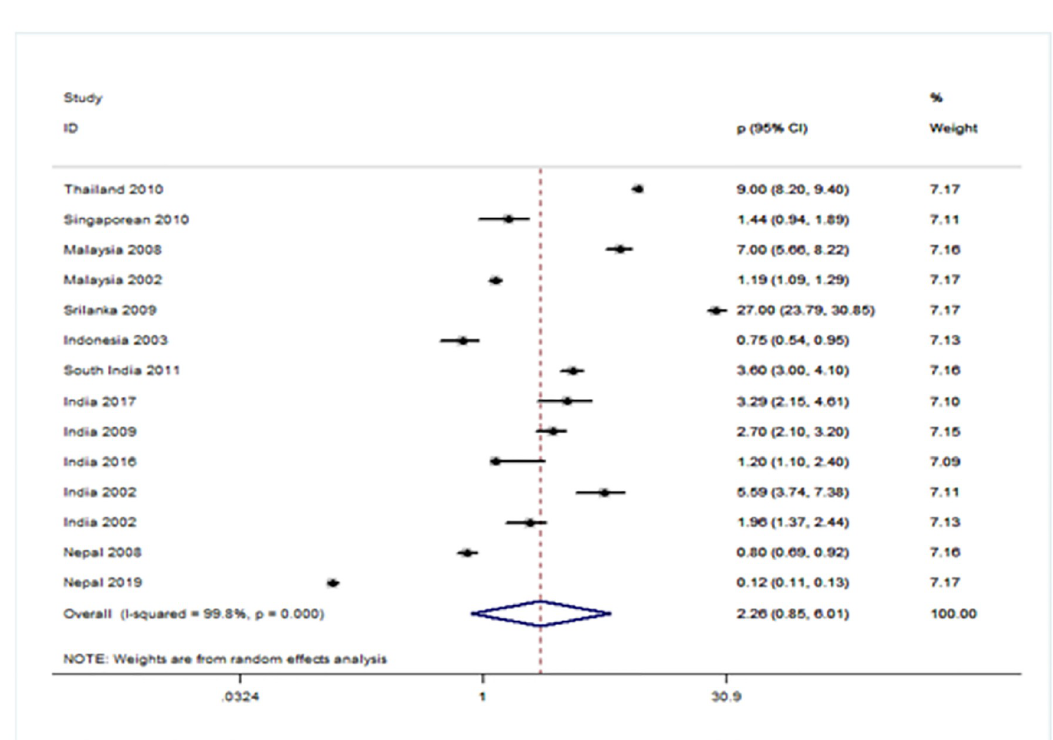
Fig 8. Forest plot showing prevalence of refractive errors among children aged < 20 years in South-East Asia region.